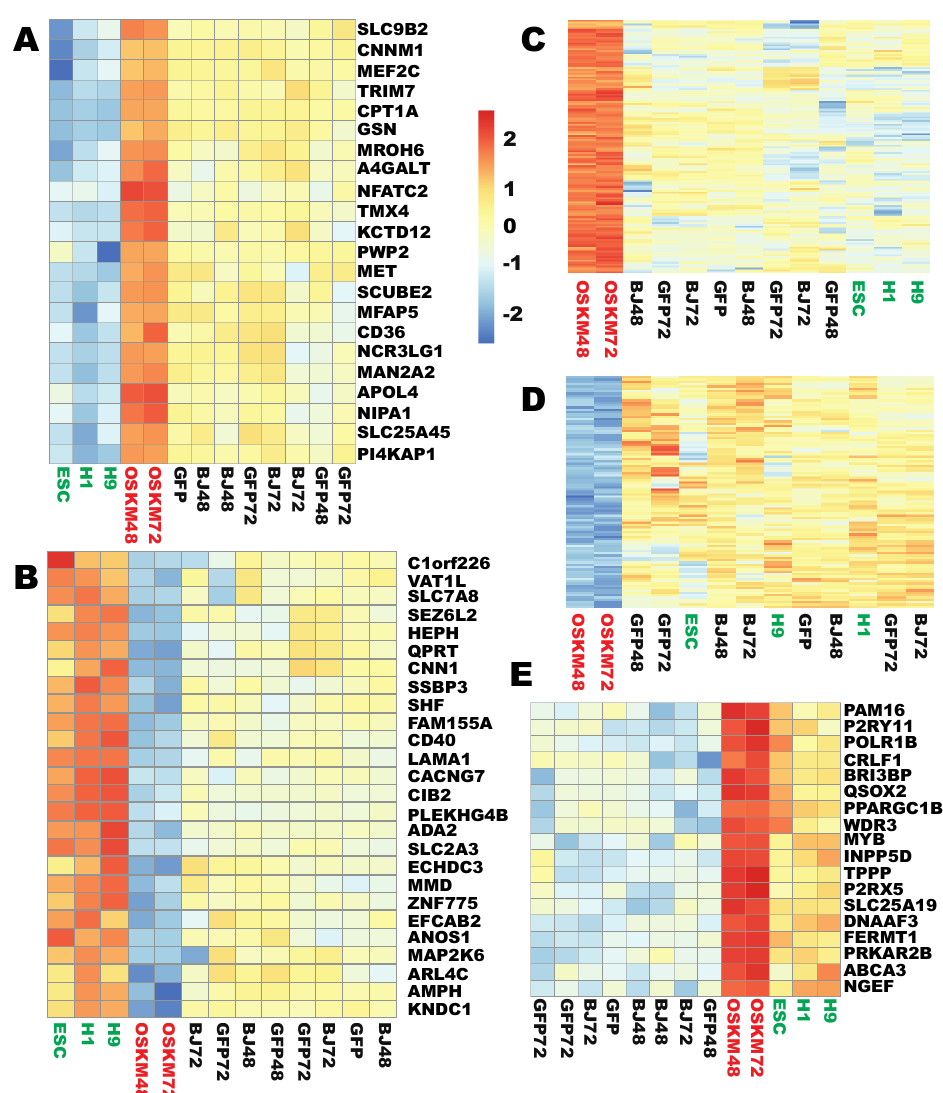
Figure 8. Five types of aberrant reprogramming by OSKM at the early stages. ( A ) A heat map showing that 22 genes were wrongly upreprogrammed. ( B ) A heat map showing that 26 genes were wrongly downreprogrammed. ( C ) A heat map showing that 134 genes underwent unwanted upreprogramming. ( D ) A heat map showing that 99 genes underwent unwanted downreprogramming. ( E ) A heat map showing that 18 genes underwent over-upreprogramming. Figure sample labels are the same as in Figure